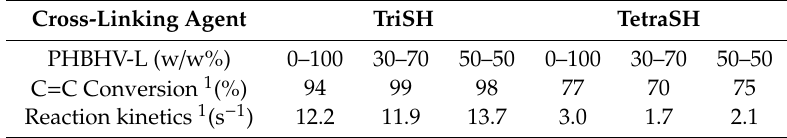
Table 2. Conversion of the PHBHV-L co-network and determination of kinetics.